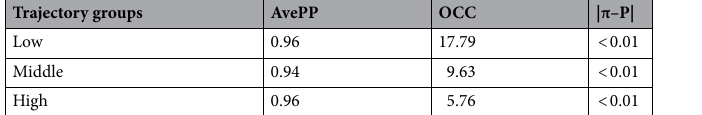
Table 2. The model fit of the best base model. AvePP, average posterior probability; OCC, odds of correct classification; P, actual proportion of subjects assigned to each trajectory group using the maximum probability rule; π, posterior probability of group